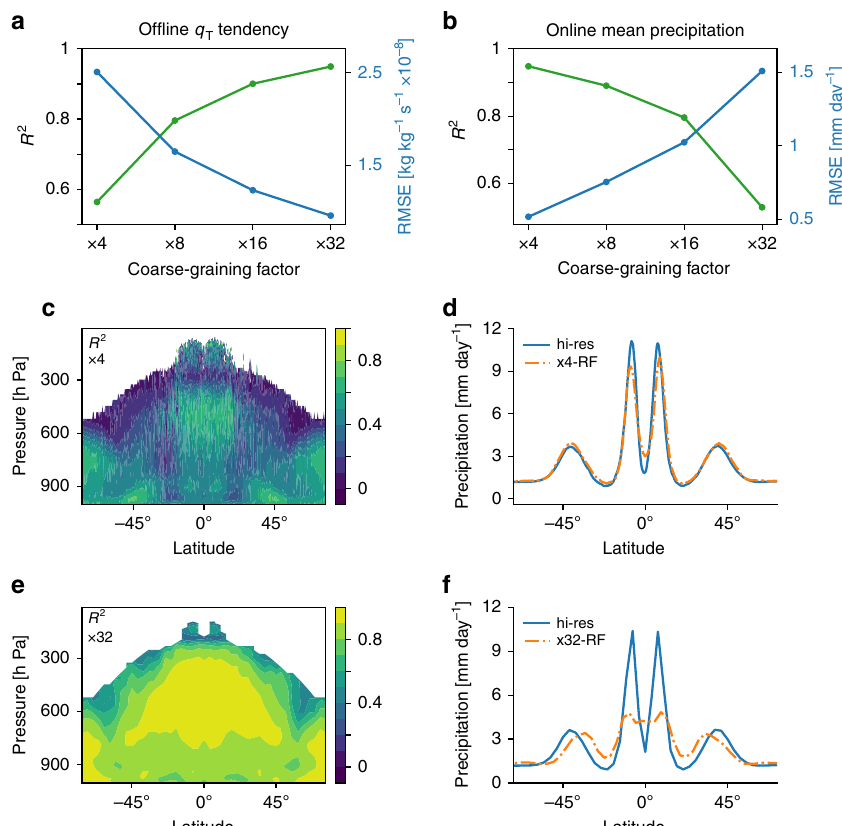
Fig. 3 Performance of random forest parameterization versus grid spacing. Panels a , c and e show of fl ine performance as measured on test data for the random forest (RF) predicted tendency of q T : a R 2 (green) and root mean square error (blue) versus grid spacing, and c , e R 2 versus pressure and latitude for c x4 and e x32. In c , e , R 2 is only shown where the variance is at least 0.1% of the mean variance over all latitudes and levels. Panels b , d and f show online performance: b R 2 (green) and root mean square error (blue) versus grid spacing for mean precipitation versus latitude, and d , f mean precipitation versus latitude for hi-res (blue) compared to d x4-RF (orange) and f x32-RF (orange).